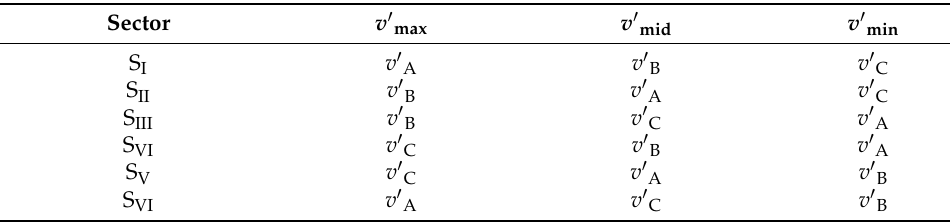
Table 3. Relationship between v (cid:48) max , v (cid:48) mid , v (cid:48) min and v (cid:48) x .